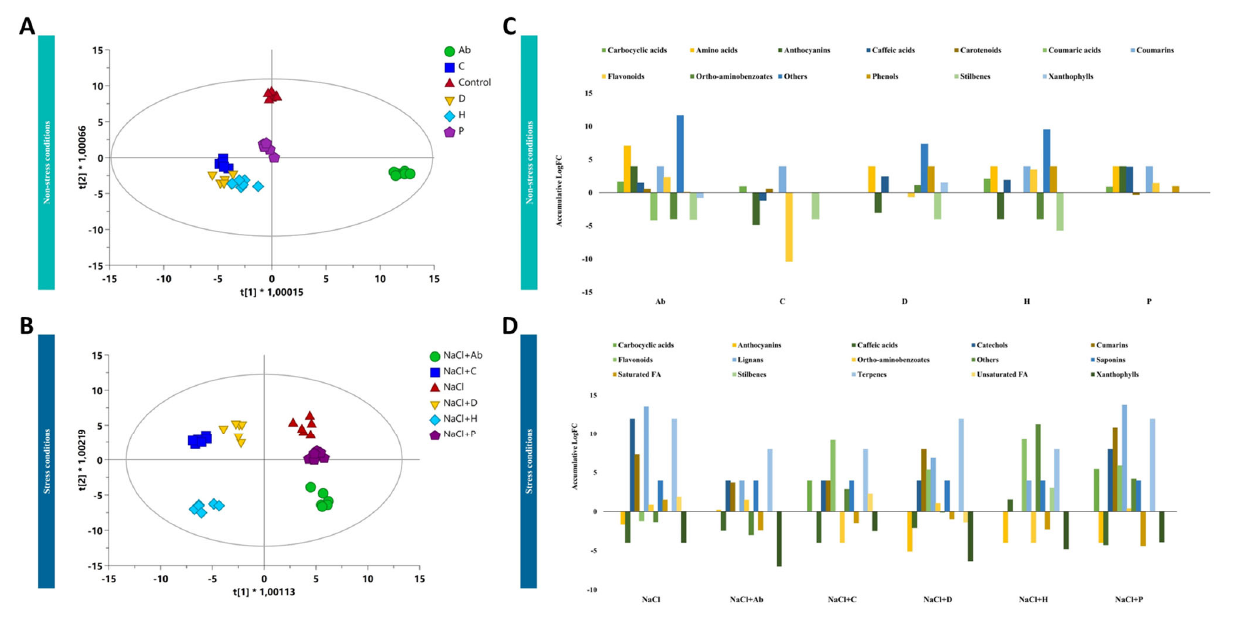
Figure 3. Supervised orthogonal projection to latent structures discriminant analysis (OPLS-DA) score plot built considering the metabolomic profile of tomato root exudates under no-salt conditions (R 2 = 0.97; Q 2 = 0.8) ( A ) and high-salt conditions (R 2 = 0.97; Q 2 = 0.8) ( B ). Significant compounds exuded by tomato plants treated with biostimulants under no-salt conditions ( C ) and high salt conditions ( D ).